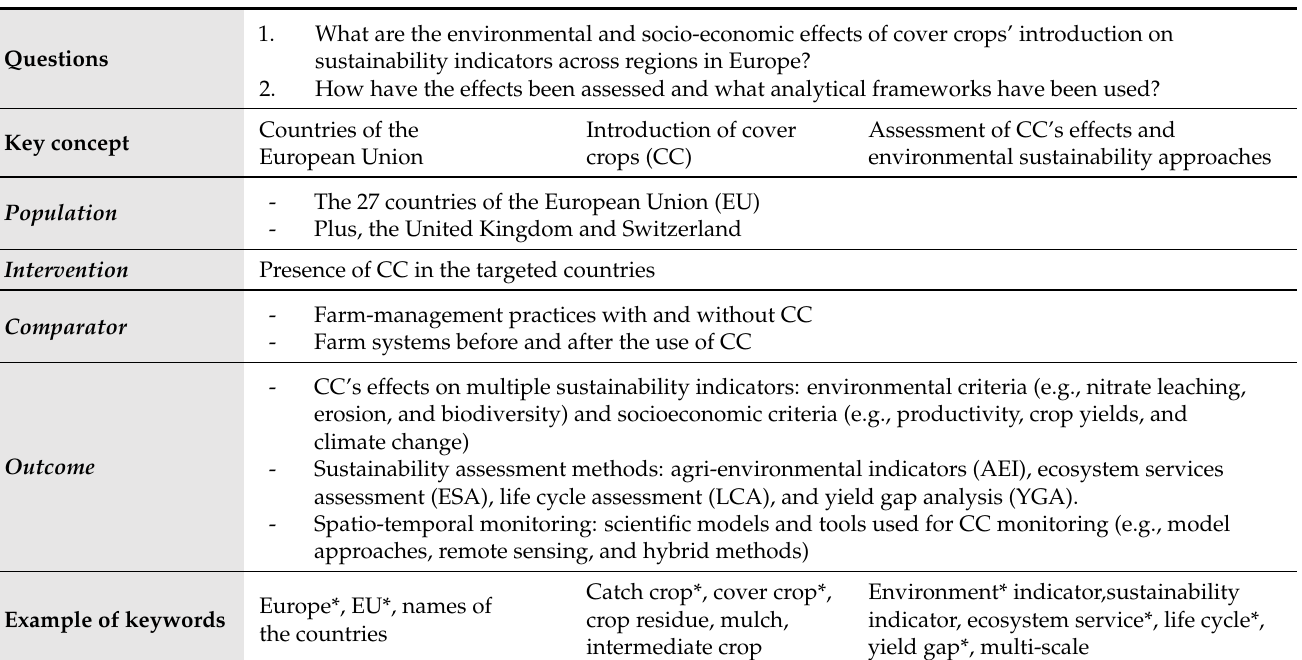
Table 1. PICO method and process for query